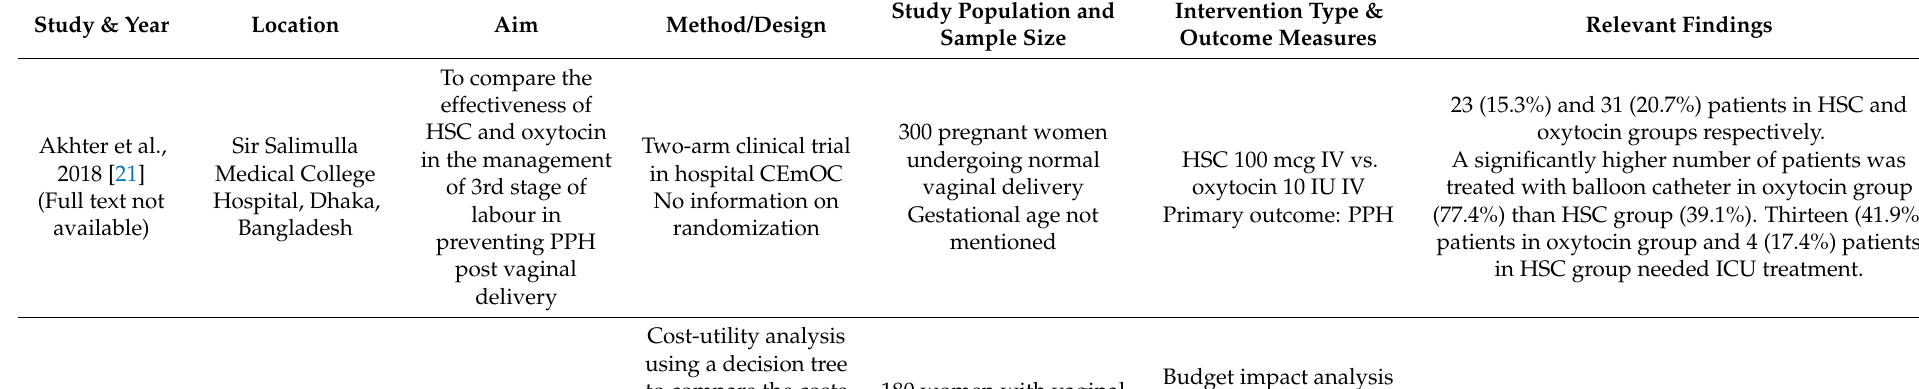
Table 2. Characteristics of included